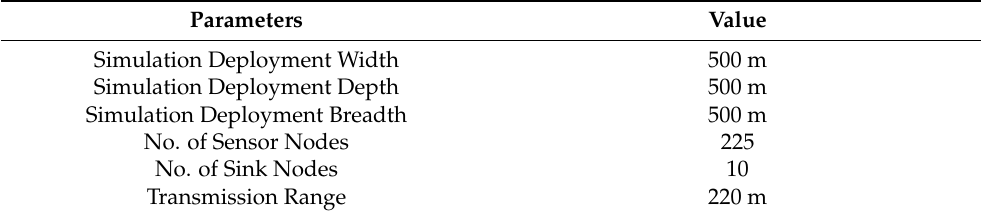
Table 2. Simulation